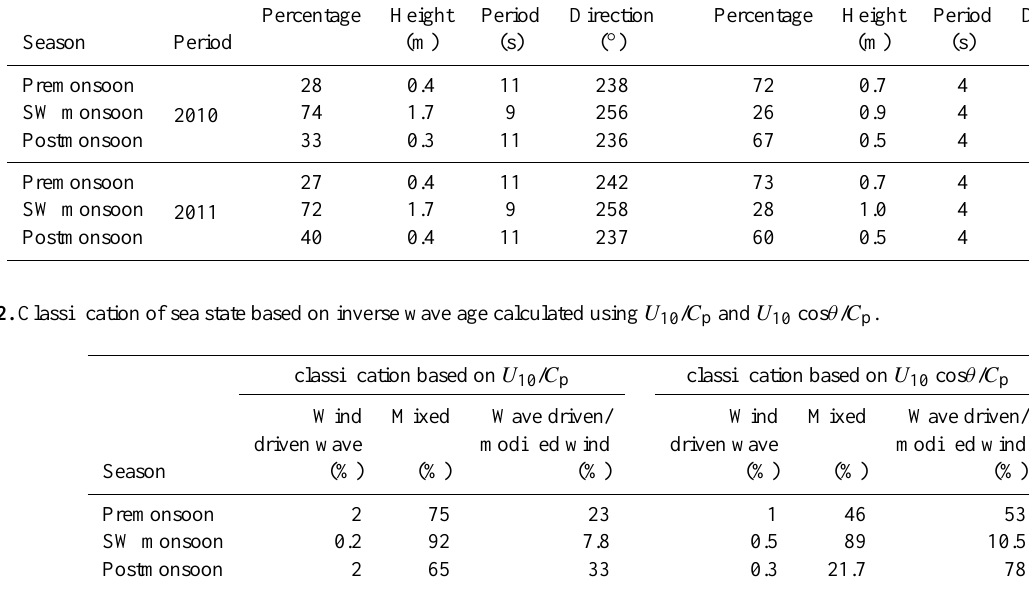
Table 1. Seasonal percentages of wind sea and swell conditions in 2010 and 2011. Swell Wind sea Percentage Height Period Direction Percentage Height Period Direction Season Period Premonsoon